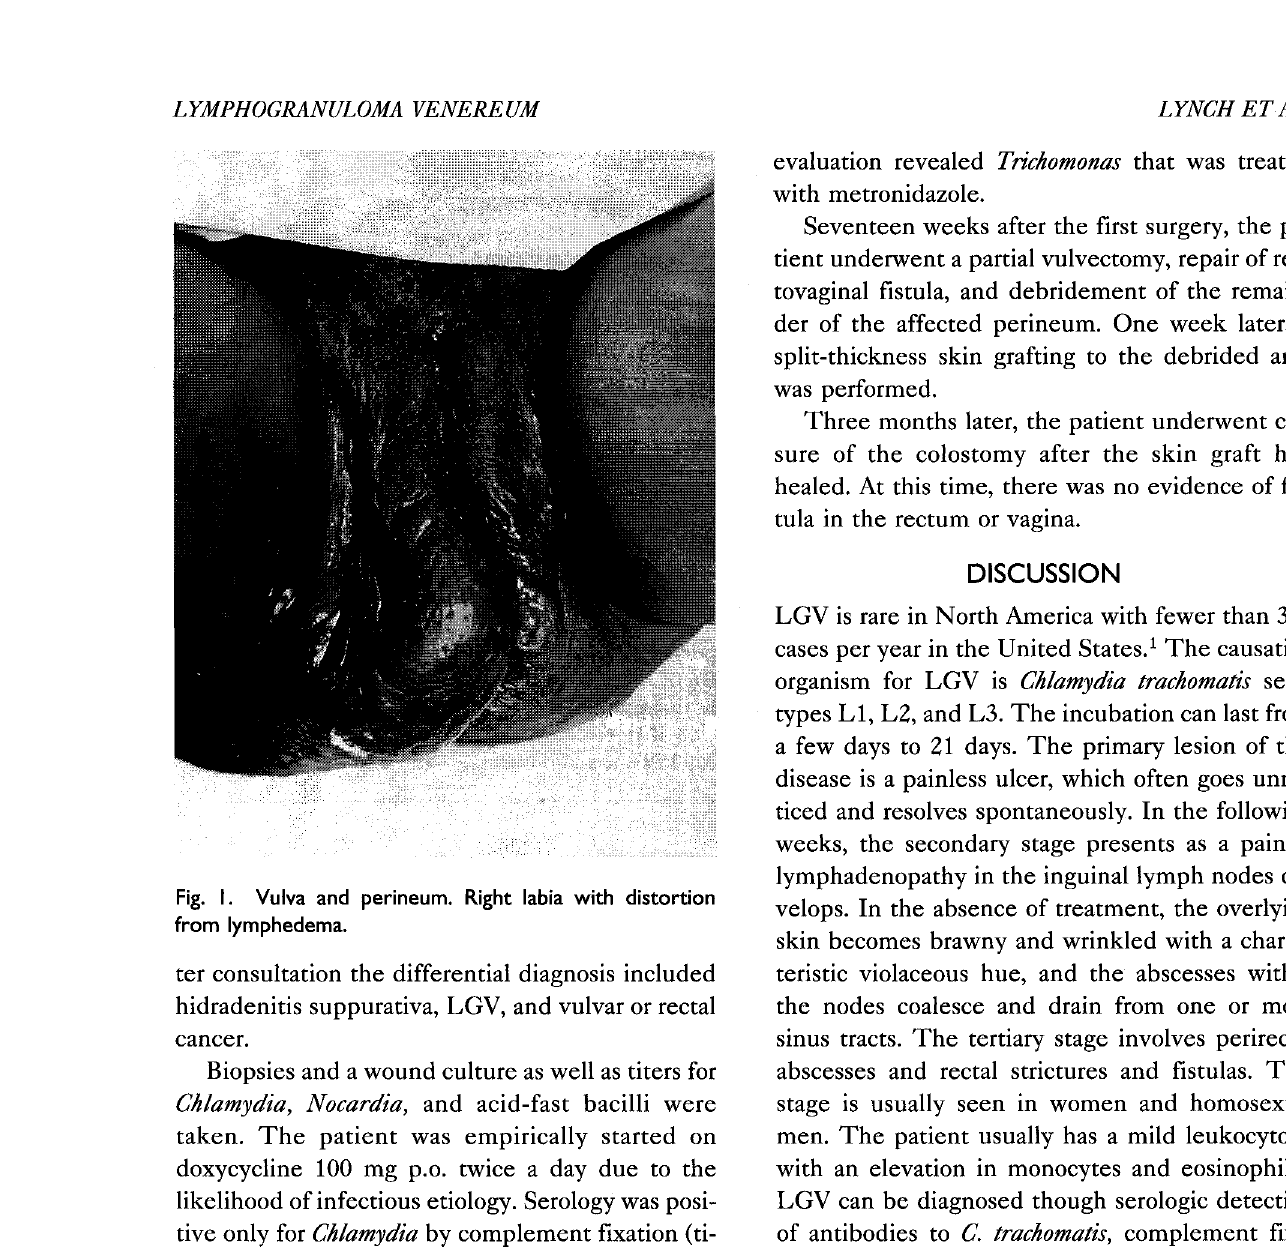
Fig. I. Vulva and perineum. Right labia with distortion from